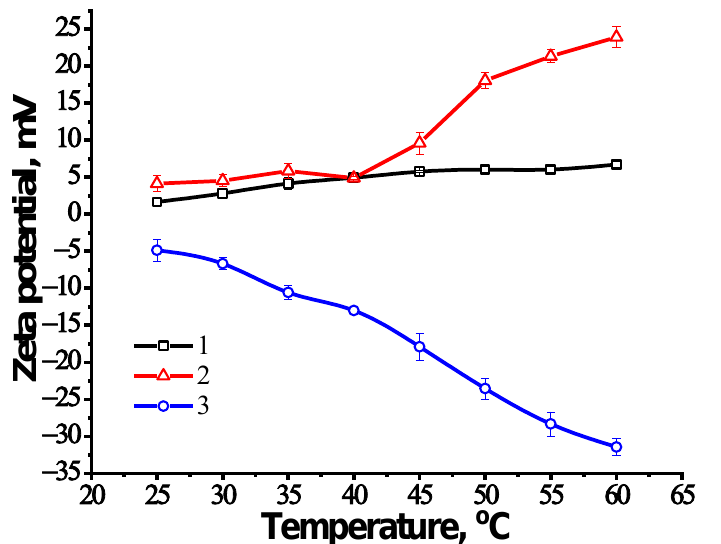
Figure 5. Zeta potential of nanogels in 0.001 M NaCl solution, with curves (1) NIPAM 90 -APTAC 5 - AMPS 5 ; (2) NIPAM 90 -APTAC 7.5 -AMPS 2.5 ; (3) NIPAM 90 -APTAC 2.5 -AMPS 7.5